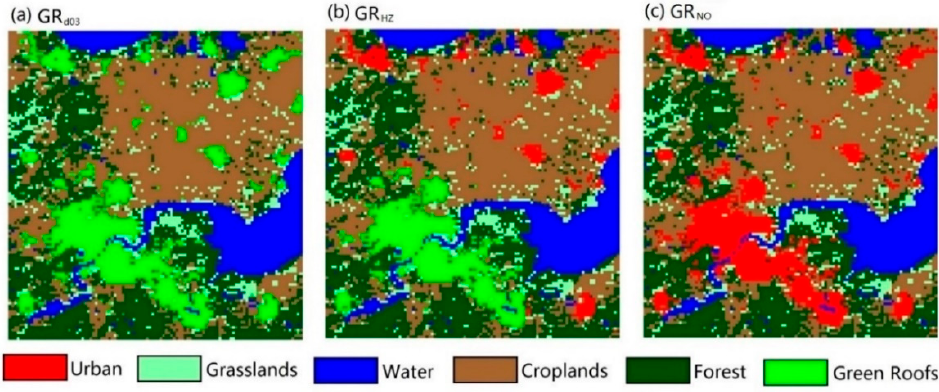
Figure 4. Land use with GRs implemented in ( a ) GR d03 all d03 urban grid roofs, ( b ) GR HZ roofs in Hangzhou urban grids, ( c ) GR NO no green roofs.